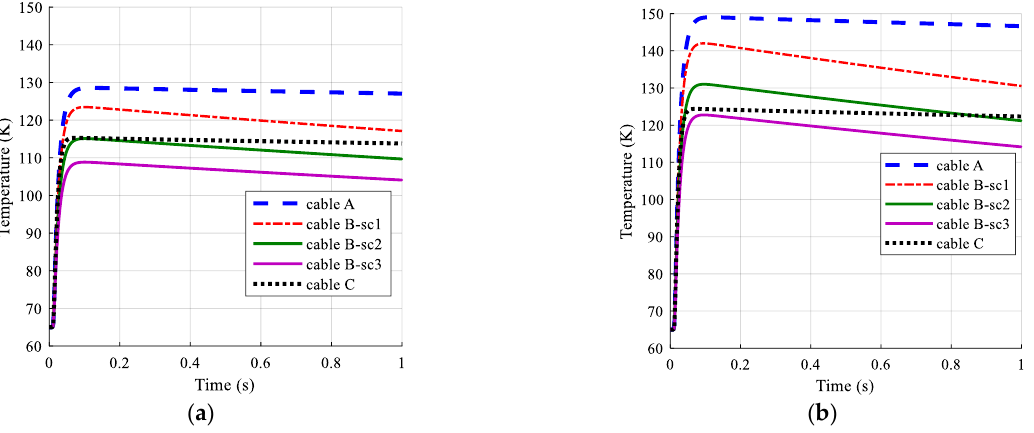
Figure 7. Temperature of the superconducting layer in each of three HTS cables, ( a ) copper former, ( b ) aluminum former.